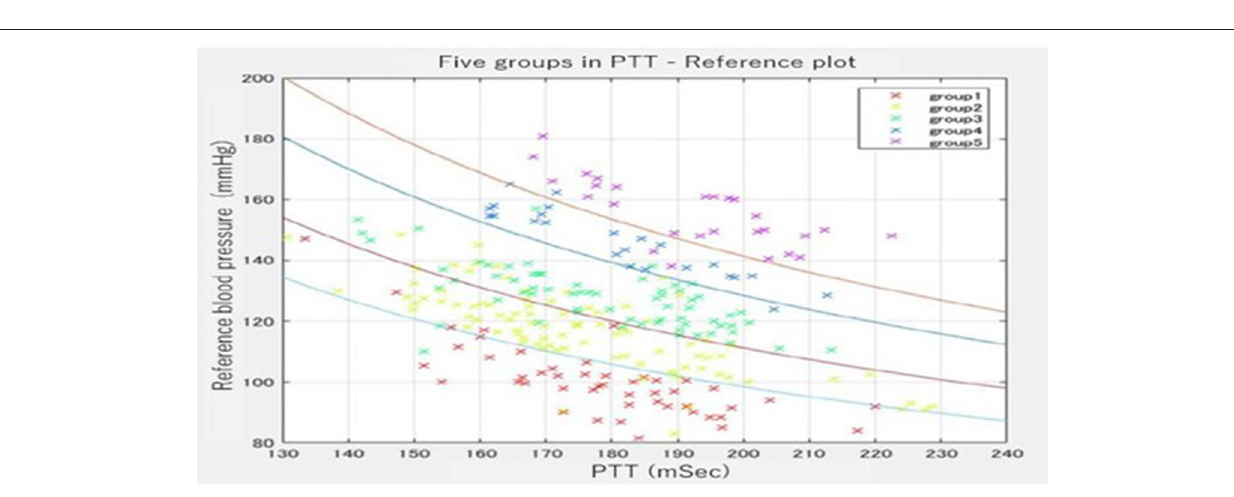
FIGURE 4 | Five groups were divided by group estimator in the PTT-reference plot. The participants were distributed 1:1:3:3:2 in the five areas surrounded by the four